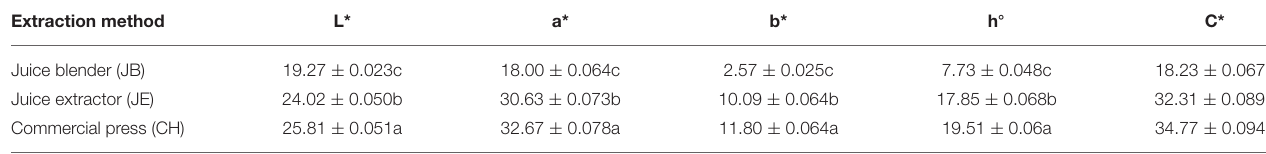
TABLE 2 | Color attributes of pomegranate juice (cv. Wonderful) extracted by using three different methods. Extraction method